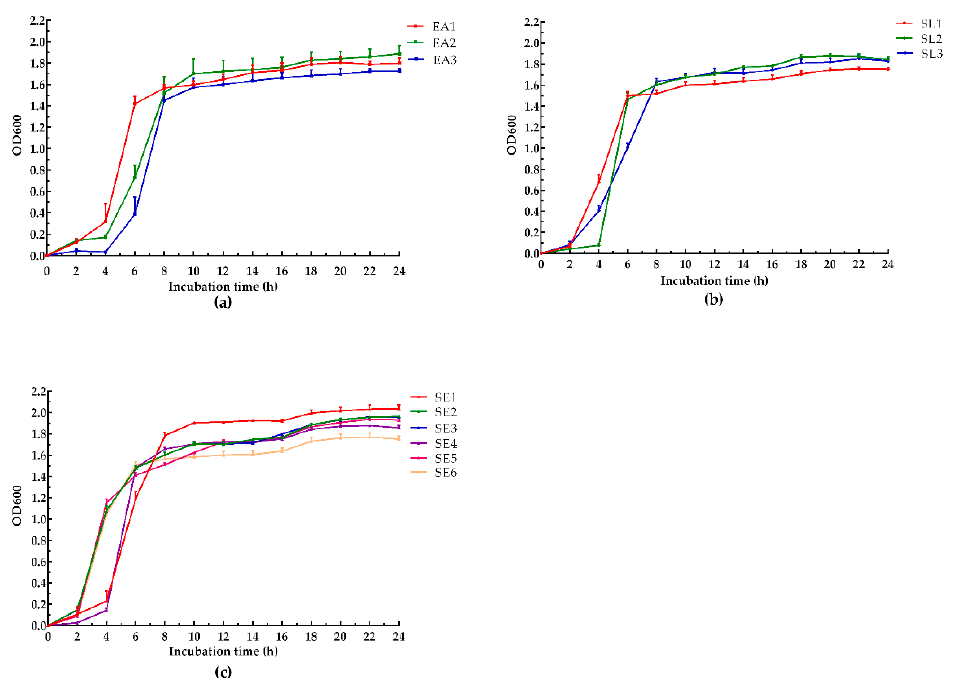
Figure 2. Growth curves (means ± SD, n = 3) of three strains of ( a ) Enterococcus avium (EA1-3); ( b ) three strains of Streptococcus lutetiensis (SL1-3); and ( c ) six strains of S. equinus (SE1-6). SL1 and SL2 arrived in the logarithmic growth phase at 2 h and 4 h of culture, respec- tively. Then, they reached the plateau phase at 6 h, with OD600 values at 24 h of 1.75 and 1.84, respectively. The lag growth phase of SL3 was observed in the first 4 h of culture. This strain reached the plateau phase at 6 h, and the final value of OD600 was 1.83 (Figure 2b). There were no significant differences among the three strains during incubation ( p > 0.05).